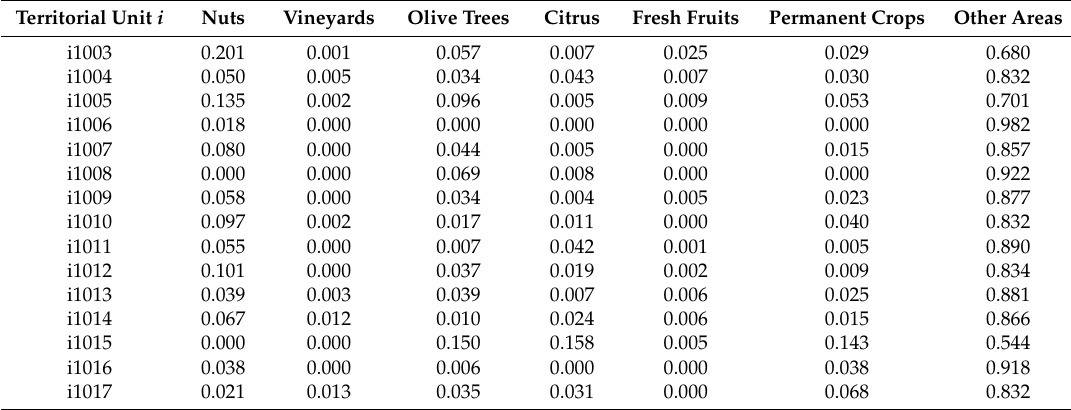
Table 1. The examples of the prior estimates i at a pixel level using the Maximum Likelihood algorithm in the Algarve region in 2009.